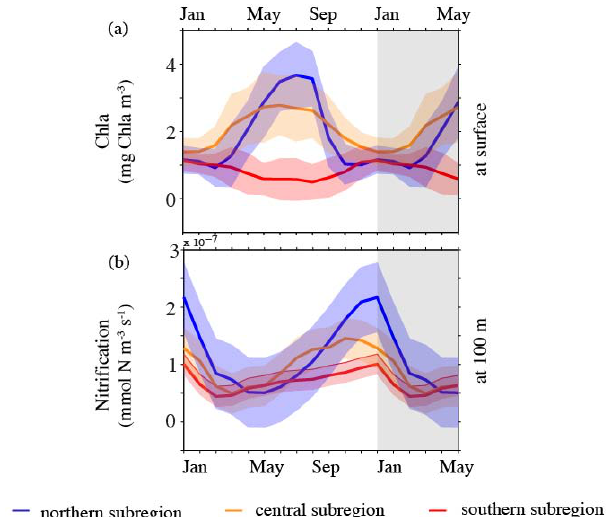
Fig. A1. Seasonal cycle of (a) surface chlorophyll a and (b) nitrification at 100m, in the nearshore 50km. The lines represent the mean and the shaded area the spatial variability ( ± 1STD) for each month, for the northern (blue), central (orange) and southern (red) subregions. The shaded area depicts the first six months of the following annual cycle.